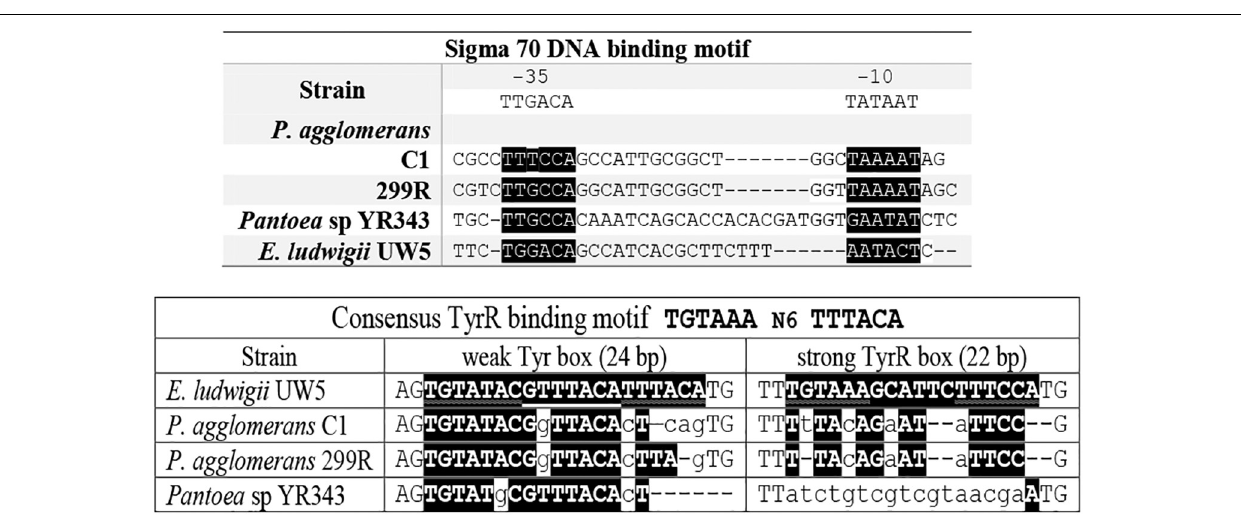
FIGURE 5 | Alignment of relevant elements of the ipdC promoter sequence of E. ludwigii UW5, P. agglomerans C1, P. agglomerans 299R, and Pantoea species YR343. The conserved nucleotides in the -10 and -35 region (upper panel) and putative TyrR binding sites (lower panel) are highlighted in